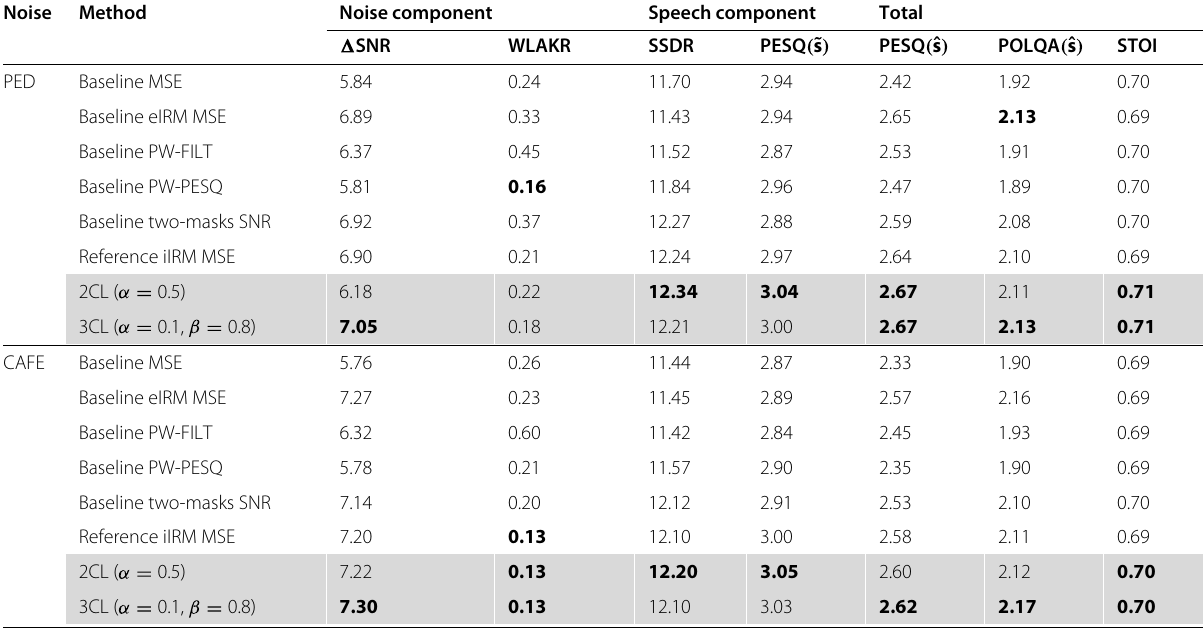
Table 6 Performance for seen noise types (PED and CAFE) on the test set ; All SNRs averaged. Best approaches from Tables 1 and 3 are gray-shaded; the best scheme is in